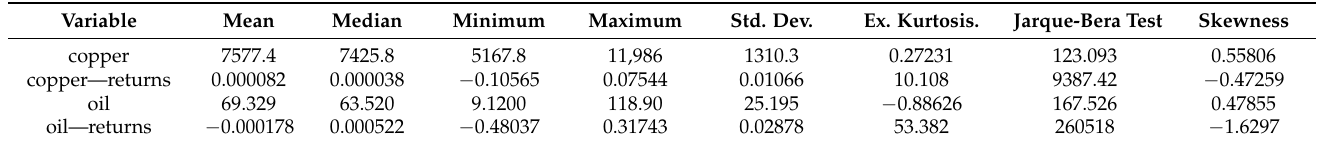
Table 4. Statistic of time-series.